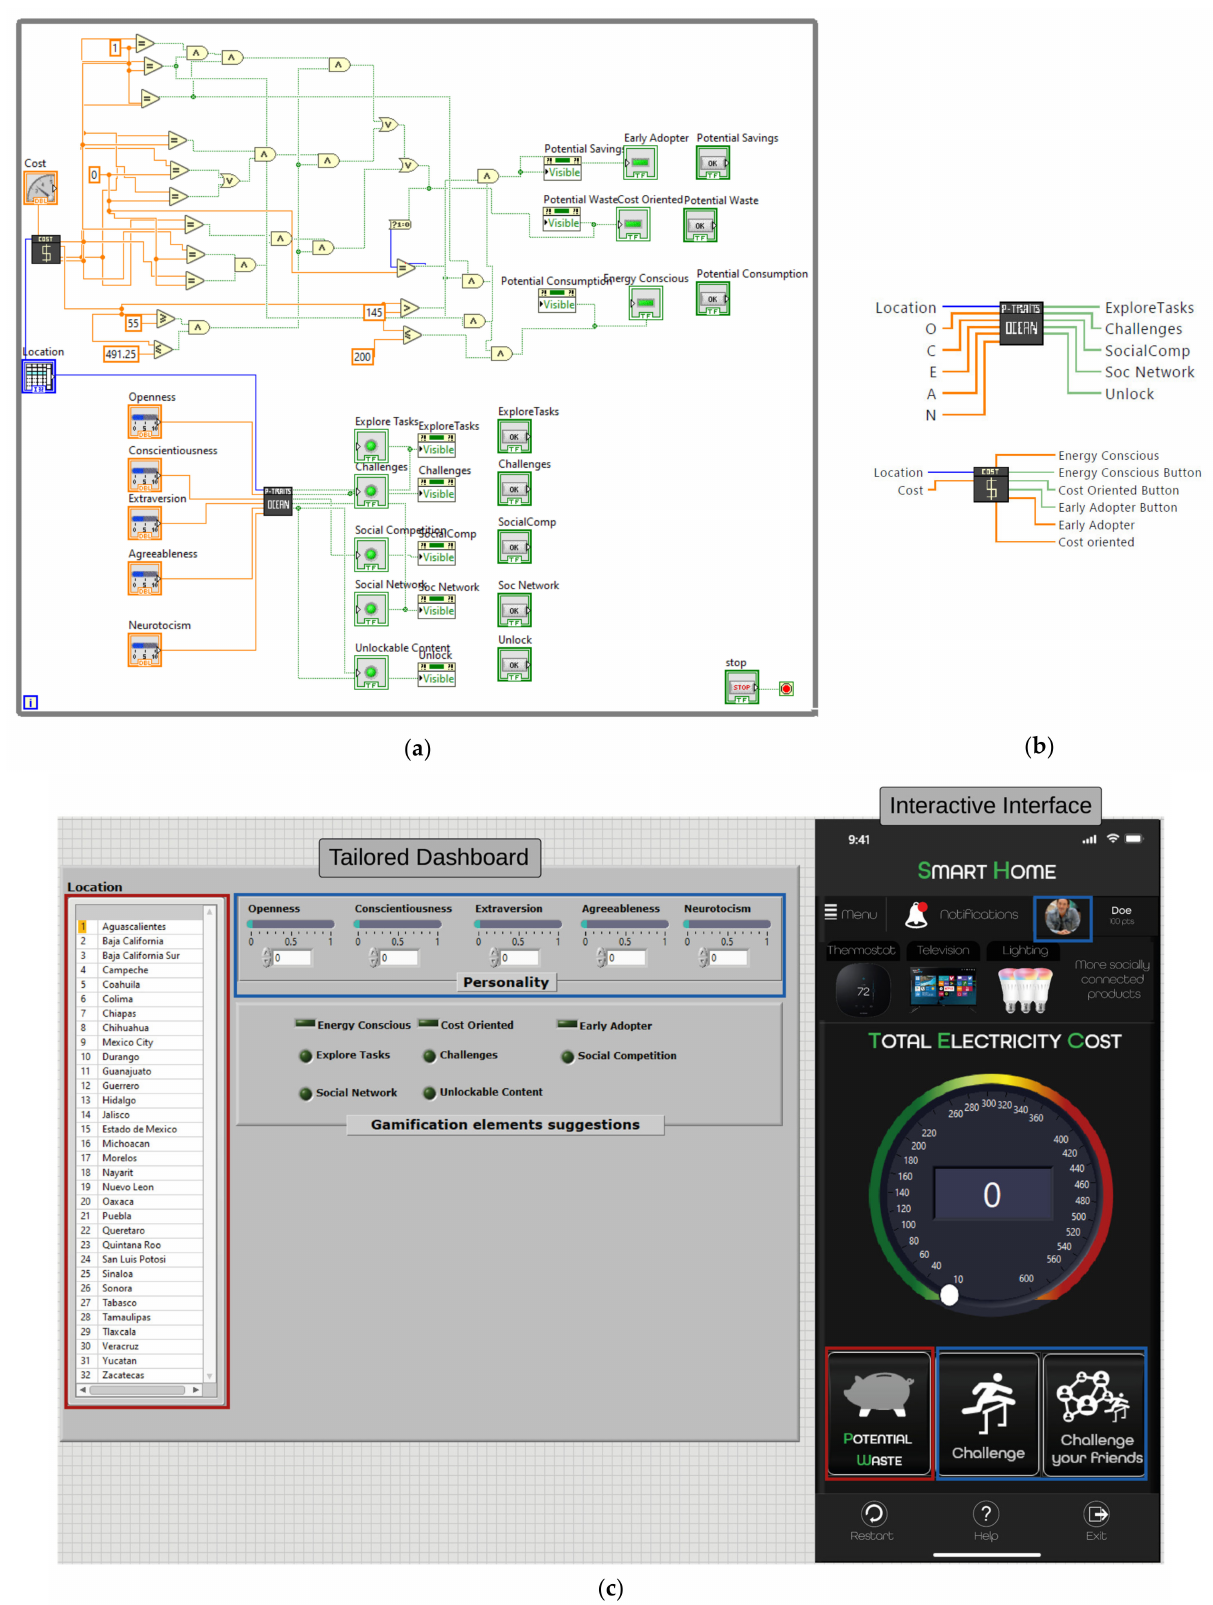
Figure 10. Proposed interactive dashboard: ( a ) block diagram, ( b ) subsystems that contain the two ANNs, and ( c ) left side: input values; right side: interactive